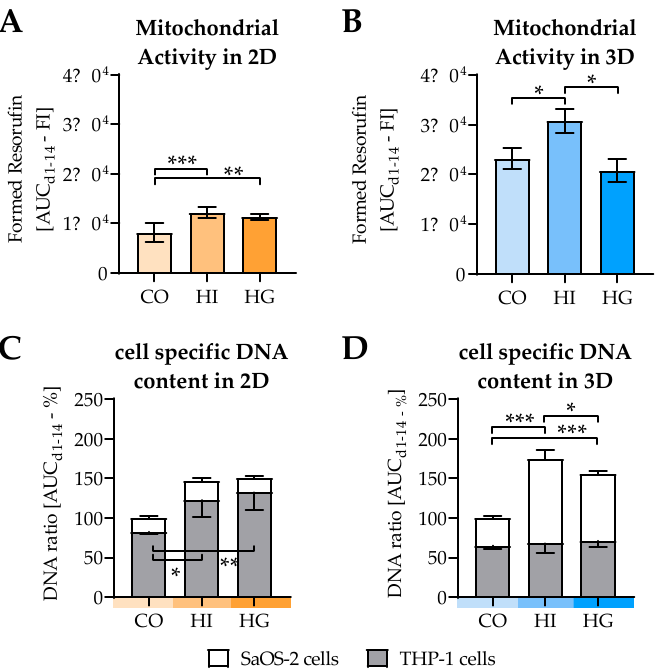
Figure 4. Influence of pre-/diabetic conditions on viability of THP-1 cells and SaOS-2 cells in 2D and 3D cocultures. THP-1 cells and SaOS-2 cells (2:1 ratio) were cocultured over 14 days in both ( A , C ) 2D and ( B , D ) 3D on pHEMA-based cryogel scaffolds in the presence or absence of high insulin levels (HI = prediabetic conditions) or high glucose levels (HG = diabetic conditions). On days 1, 4, 7, 10, and 14 of culture, ( A , B ) mitochondrial activity (Resazurin conversion) and ( C , D ) cell-specific DNA content were determined. To consider the entire differentiation period, data are presented as area under the curve (AUC / mean ± SEM). Mitochondrial activities were compared by nonparametric Friedmann test, followed by Dunn’s multiple comparison test. Cell-specific DNA contents were compared by nonparametric two-way ANOVA, followed by Tukey’s multiple comparison test. * p < 0.05, ** p < 0.01, and *** p < 0.0001 as indicated. N = 3, n = 3.